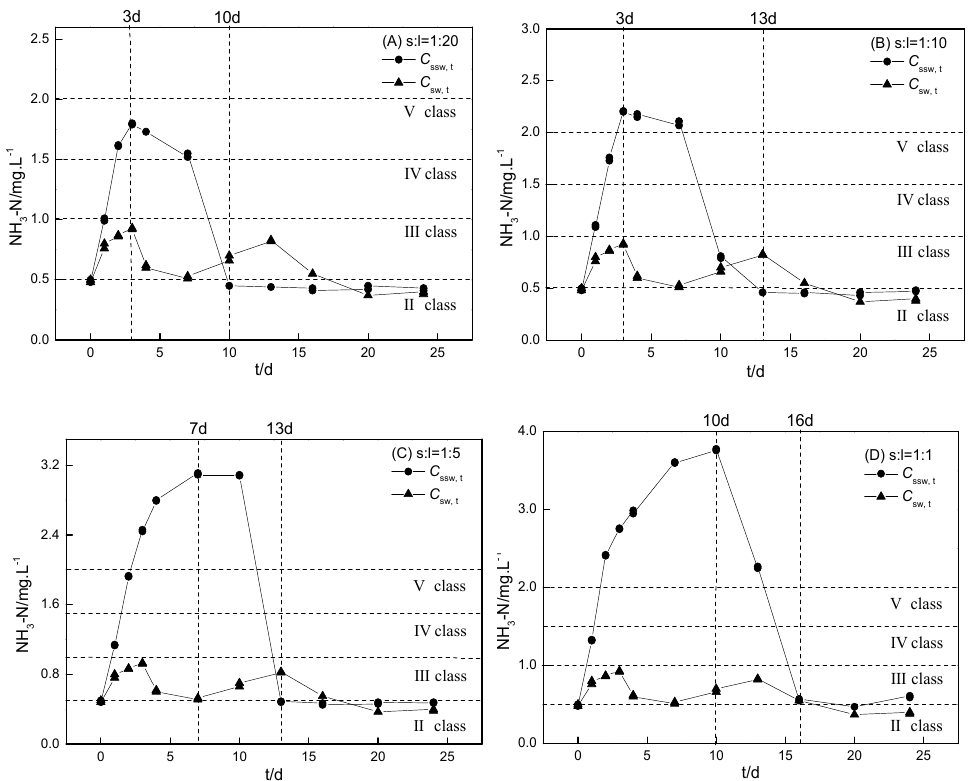
Figure 4. Kinetics of ammonium with sediment (S1) incubation at different sediment-to-water ratios in sample water ( C ssw, t ). The sediment-to-water ratios for ( A ), ( B ), ( C ), and ( D ) were 1:20, 1:10, 1:5, and 1:1, respectively. The controls were the kinetics of ammonium incubation in the sample water ( C sw, t ) without sediments.